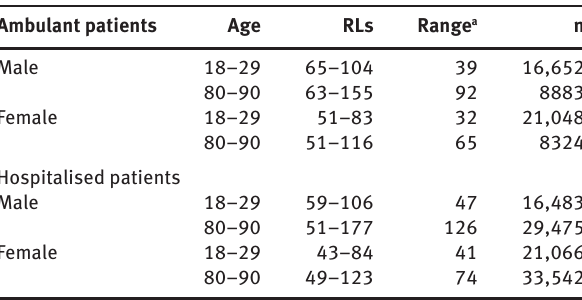
Table 3: Reference intervals ( μ mol/L) with range and number (n) of distributions of creatinine concentrations in heparinised plasma (laboratory 3).